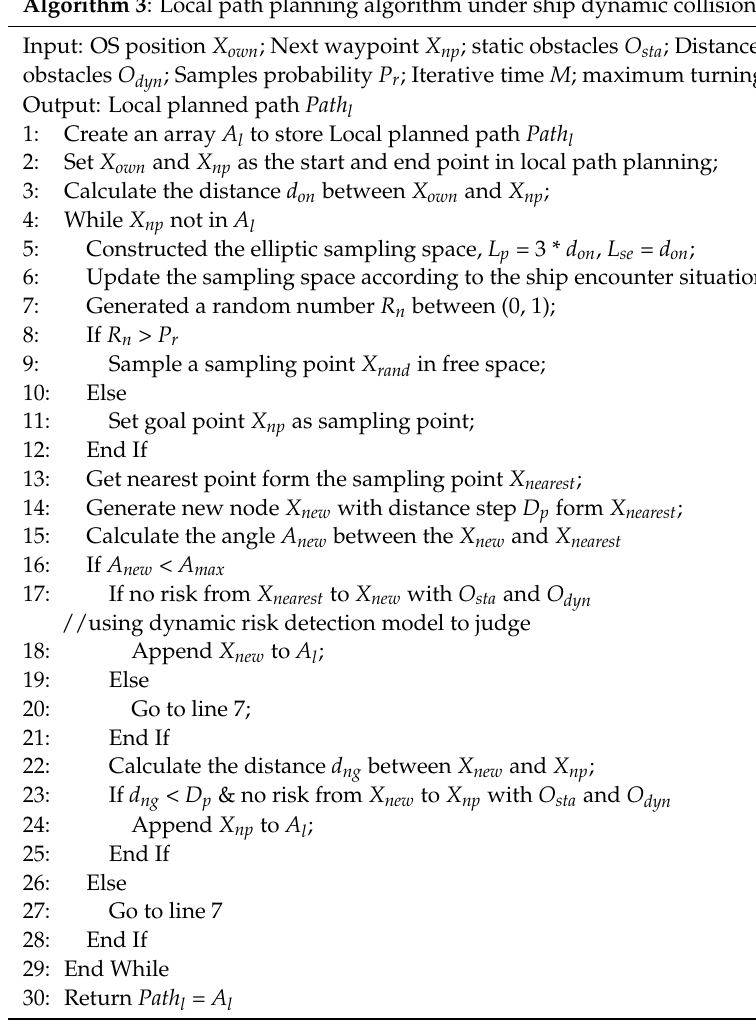
Algorithm 3 : Local path planning algorithm under ship dynamic collision risk